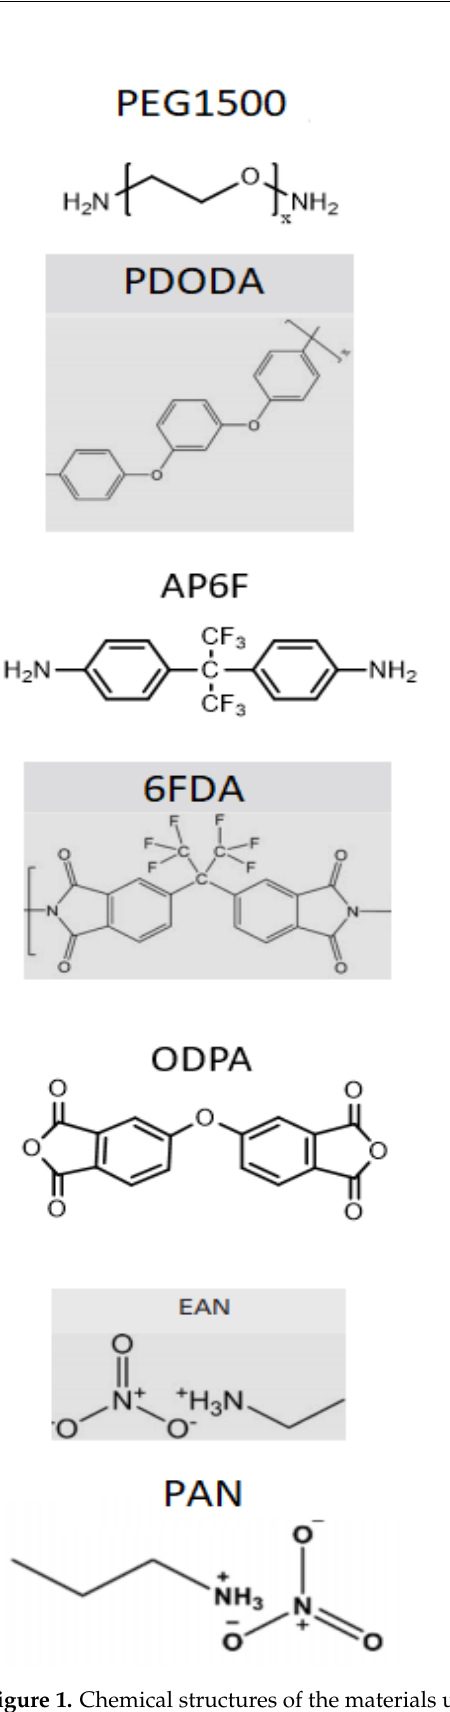
Figure 1. Chemical structures of the materials used in the two-step production method.